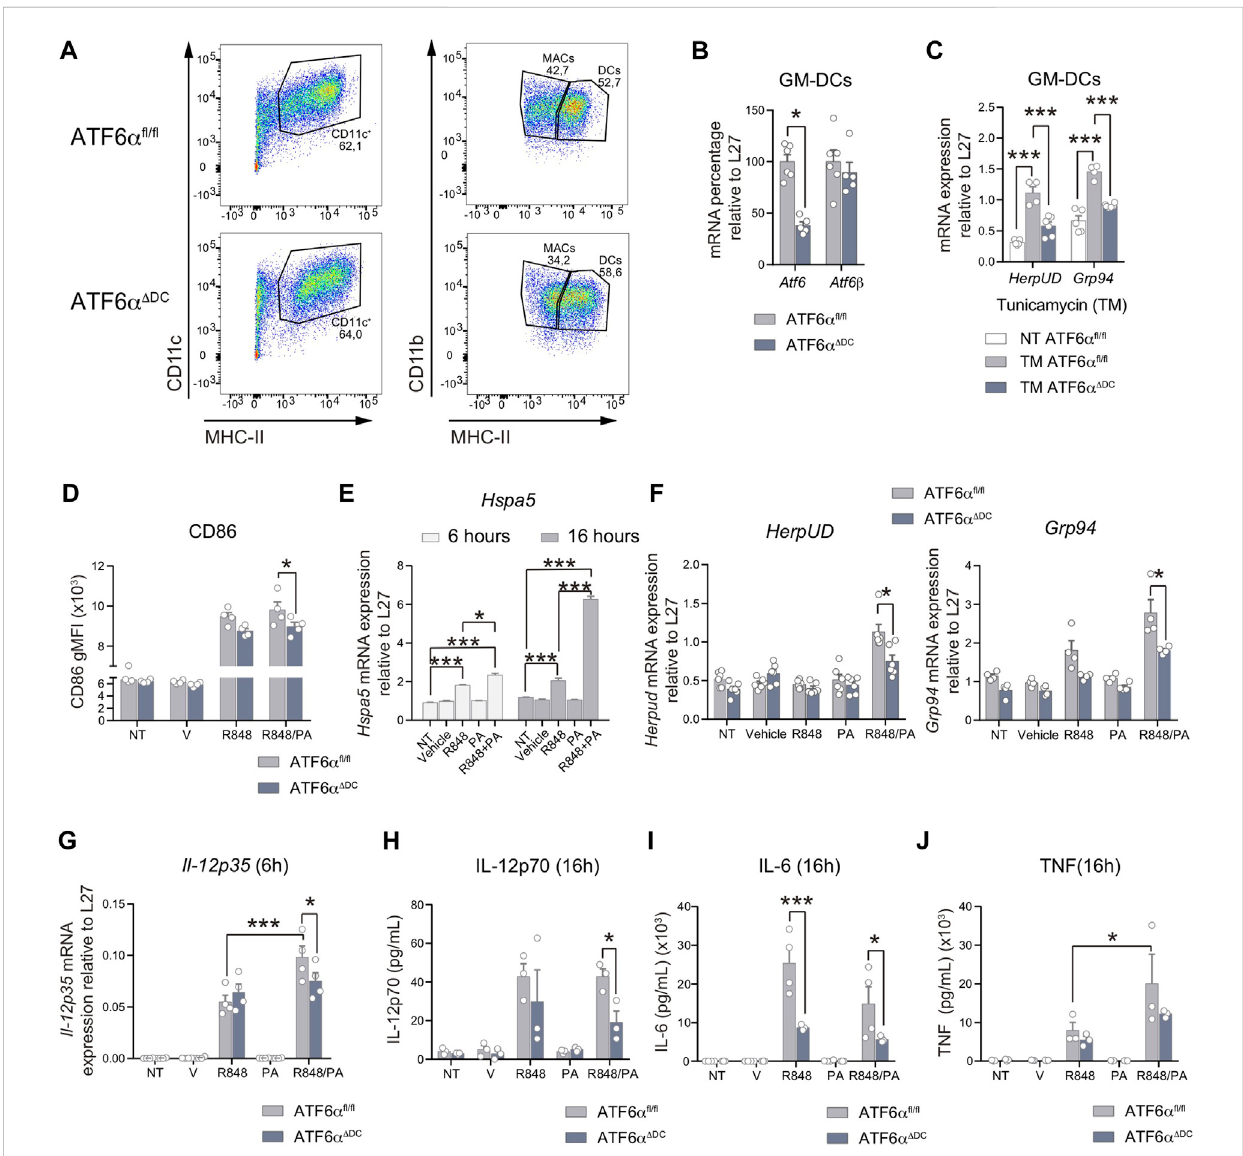
FIGURE 5 ATF6 α regulates IL-12 and IL-6 production by activated DCs (A) Representative fl ow cytometry plots of GM-DCs from ATF6 α fl / fl and ATF6 α Δ DC mice. Cells weregated as singlets, live,CD11b + , CD11c + , MHC-II + . (B) Quanti fi cationof Atf6 and Atf6b mRNA in GM-DCs from ATF6 α fl / fl and ATF6 α Δ DC mice ( n = 5 – 6). (C) Expression of the ATF6 α targets Herpud and Grp94 in ATF6 α su fi cient or de fi cient GM-DCs stimulated with tunicamycin (TM) ( n = 3). (D) Flow cytometryanalysisofCD86inGM-DCsfromATF6 α fl / fl andATF6 α Δ DC micestimulatedwithR848(5 μ g/mL)withorwithoutpalmiticacid(0,5 mM,PA) for 16 h. GM-DCs were pre-gated as singlets, live, CD11b + , CD11c + , MHC-II high . (E) Expression of Hspa5 (BiP) mRNA in GM-DCs from ATF6 α fl / fl activated withtheindicatedstimulifor6and16 h. (F) Expresionof Herpud and Grp94 inGM-DCsfromATF6 α fl / fl andATF6 α Δ DC miceandactivatedwiththeindicated stimuli for 24 h ( n =4 – 6). (G) Il-12p35 mRNA expresioninGM-DCsfrom ATF6 α fl / fl and ATF6 α Δ DC mice and activated with theindicated stimuli for 6 h ( n = 4).MeasurementofsecretedcytokinesIL-12p70 (H) ,IL-6 (I) ,TNF (J) from supernatantsofGM-DCs from ATF6 α fl / fl andATF6 α Δ DC mice, andstimulated for 16 h ( n = 3, 4). For statistical analyses, a non-parametric Mann-Whitney test was used, * p <